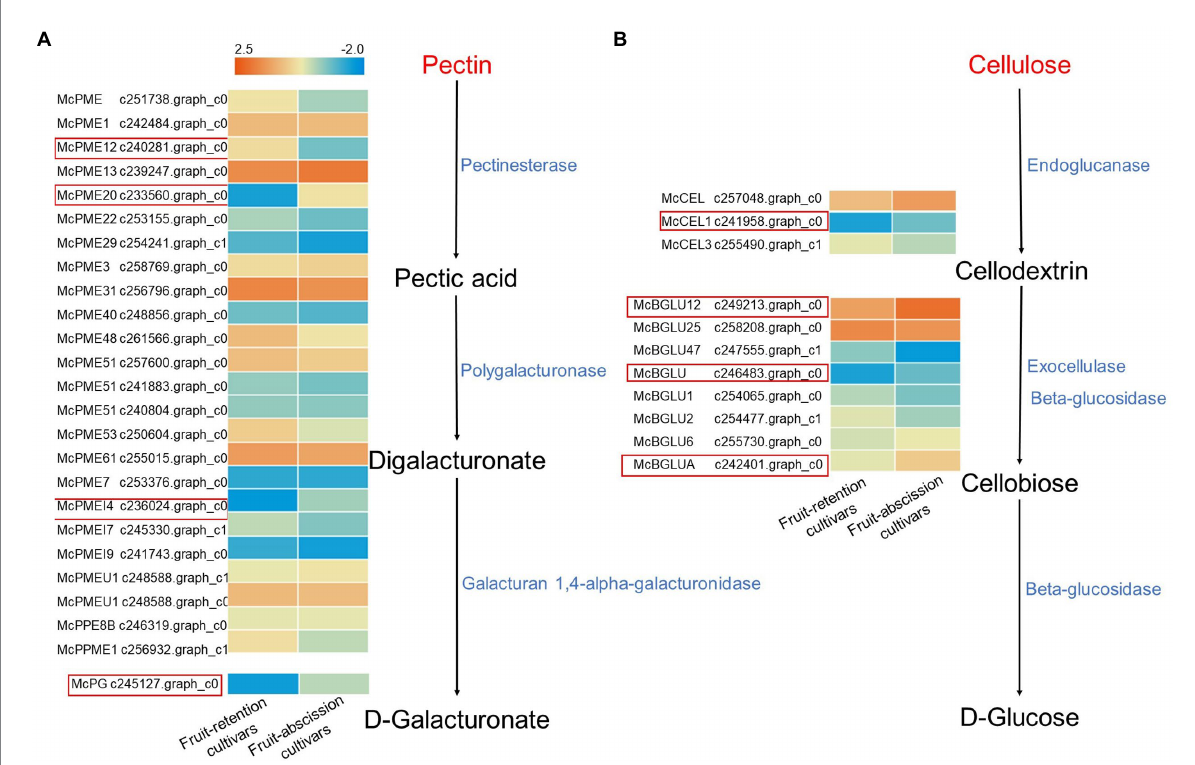
FIGURE 5 Schematics of metabolic differential transcript profiles of cellulose and pectin synthesis related genes. Genes up- or downregulated in all stages in fruit-retention and -abscission cultivars are denoted by light orange and blue, respectively. (A) Pentin; (B)